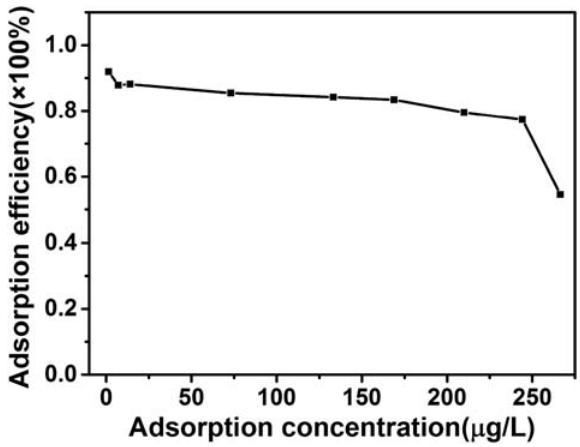
Figure 5: The adsorption e ffi ciency response curve to di ff erent Hg 2 +